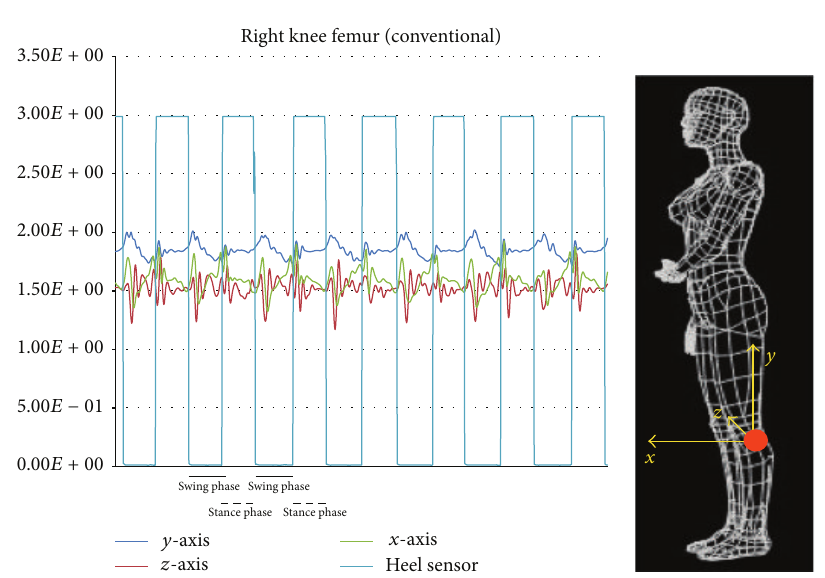
Figure 3: Sensors.